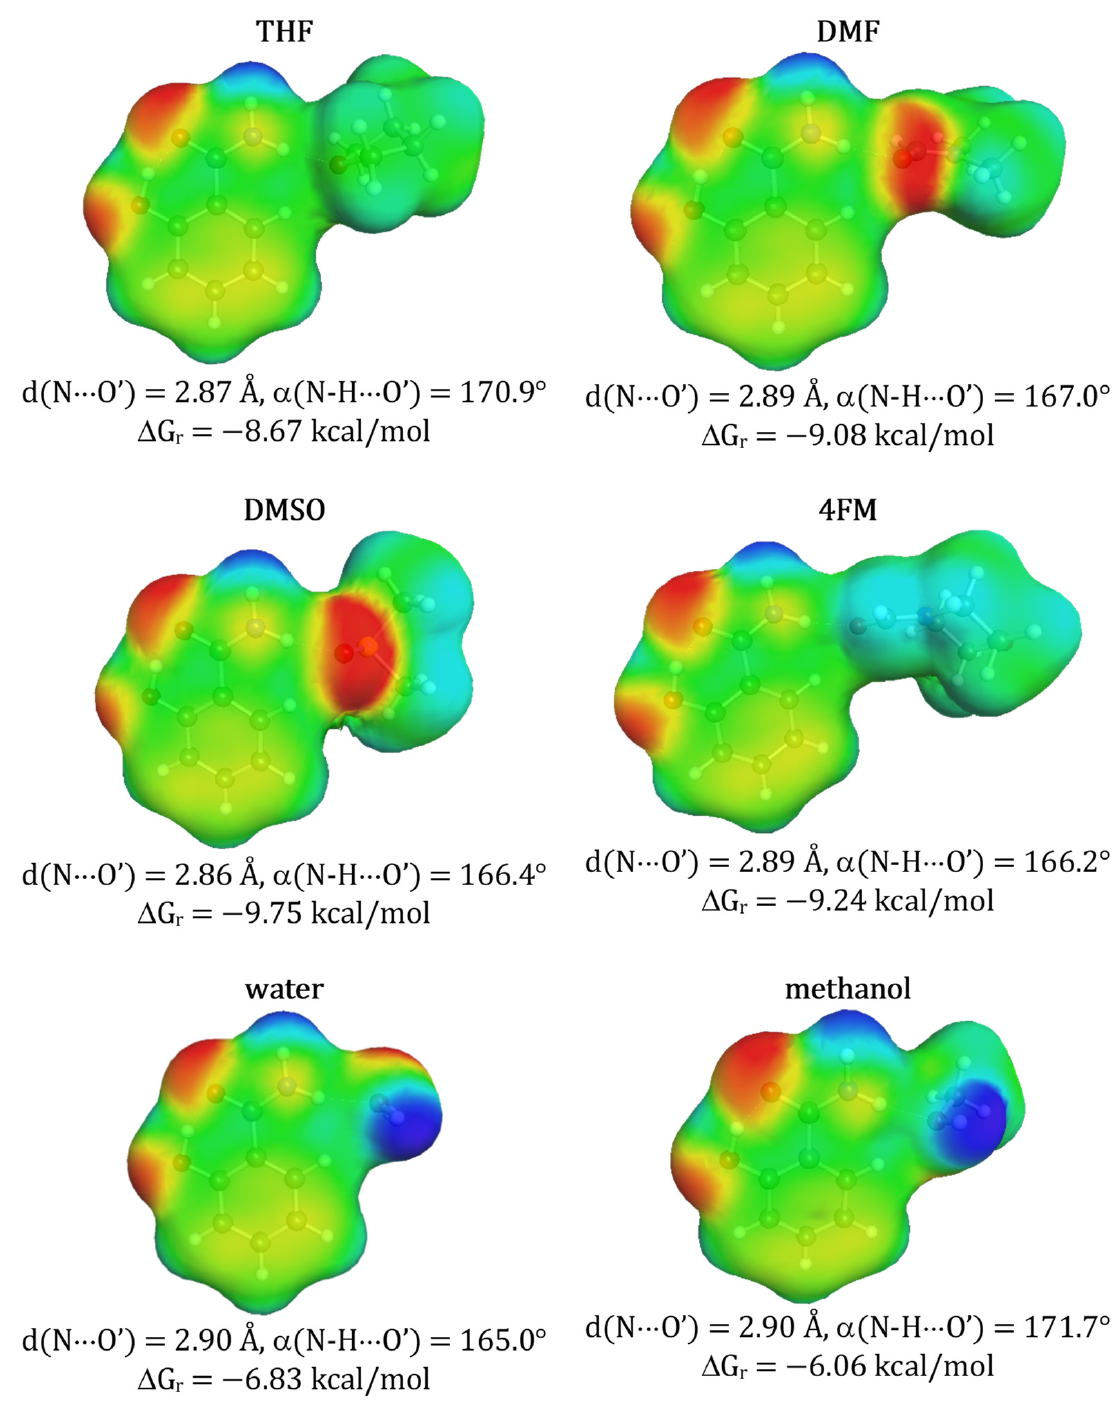
Figure 6. Structural and thermodynamic characteristics of selected solute-solvent contacts of salicylamide. Notation is the same as in Figure 1.